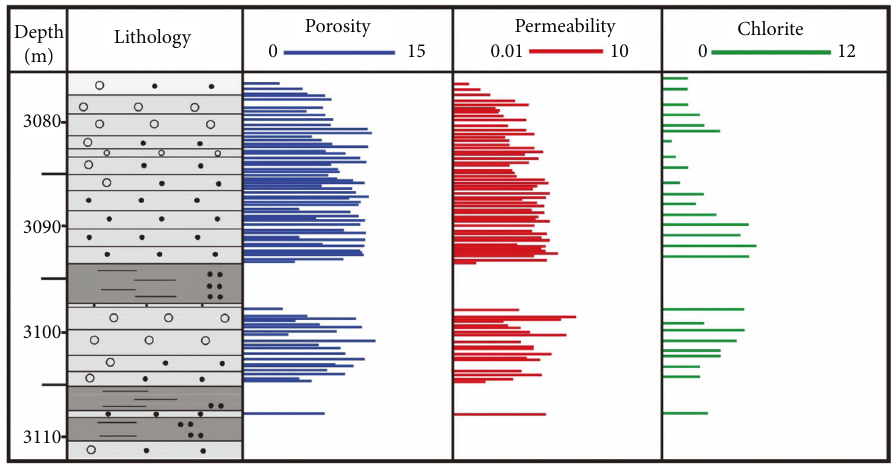
Figure 6: The relationship between porosity, permeability, and chlorite content in the core section of well B202. Table 2: Statistical table of the hole ratio of the chlorite development section in the pore lining of well B202. No.